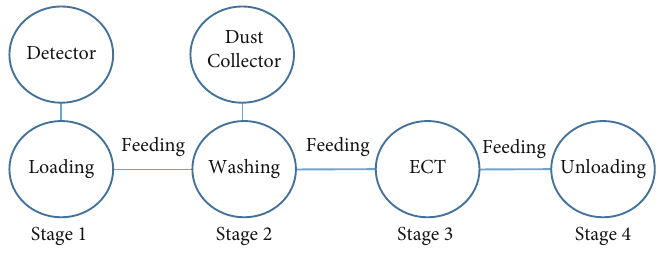
Figure 3: Process of equipment for washing and nondestructive inspection of stud